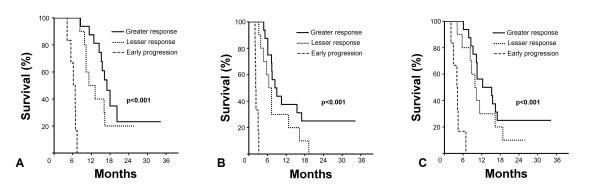
Comparative survival analyses between patients with greater PET-CT response, lesser PET-CT response and early progression. A: Overall survival (OS); B: Progression-free Survival (PFS); C: Local Regional Progression-free Survival (LRPFS). Solid line: greater response; Doted line: lesser response; Dashed line: early progression.